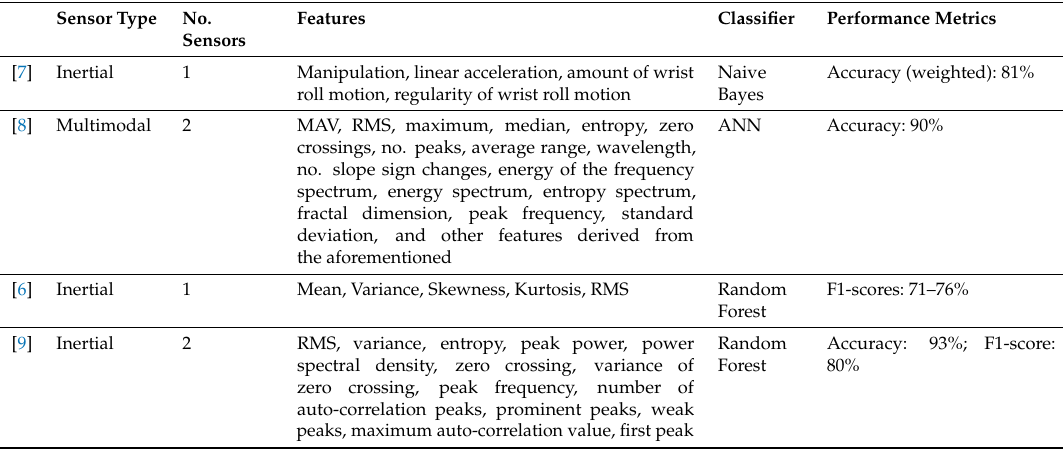
Table 2. Summary of eating detection and recognition works, validated in free-living